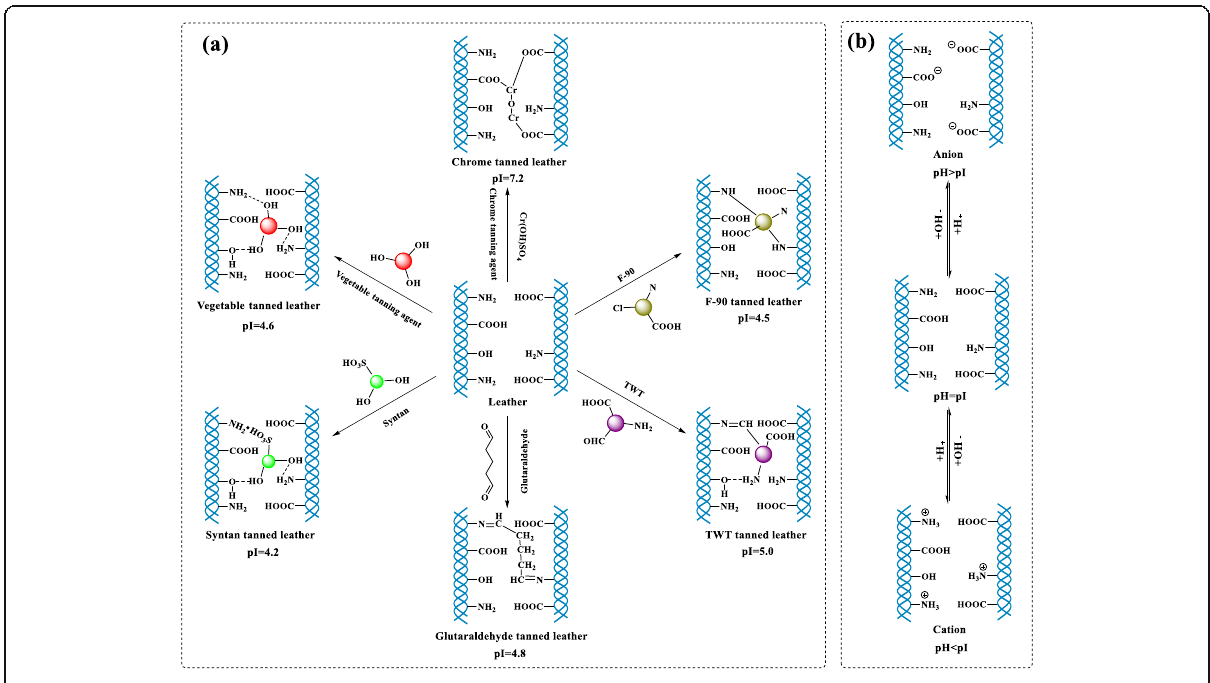
Fig. 2 a Mechanism of action between several tanning agents and polar groups in collagen fibers and the isoelectric points of leather after tanning [33 – 35]; and b electric charge of leather under different pH